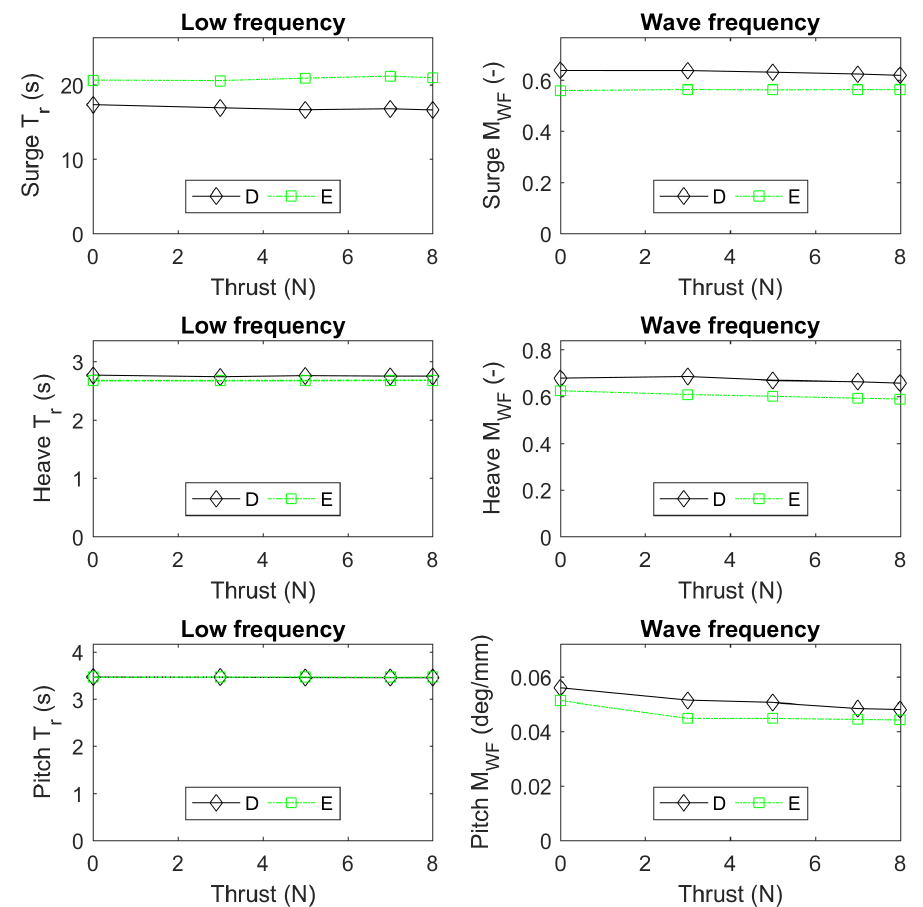
Figure 26. Metrics T r (left column) and M WF (right column) for surge (top row), heave (middle row), and pitch (bottom row) for the Pink-Noise waves produced during campaigns D and E with thrust levels 0, 3, 5, 7, and 8